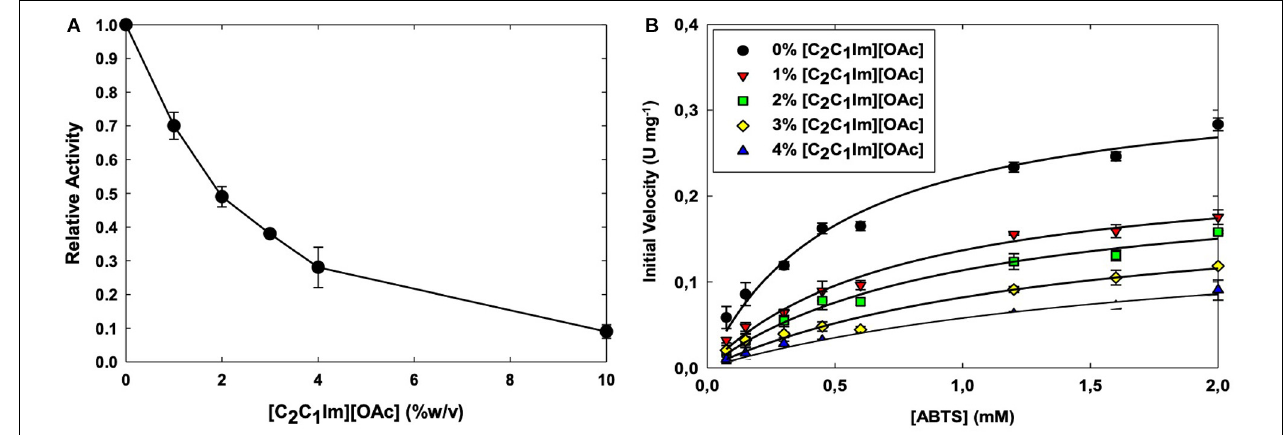
FIGURE 1 | Activity of the WT TtL in different concentrations of [C 2 C 1 Im][OAc] (A) . Michaelis–Menten curves of TtL in different concentrations of [C 2 C 1 Im][OAc] (B) . Values shown are mean with error bars representing the SD of three experiments.